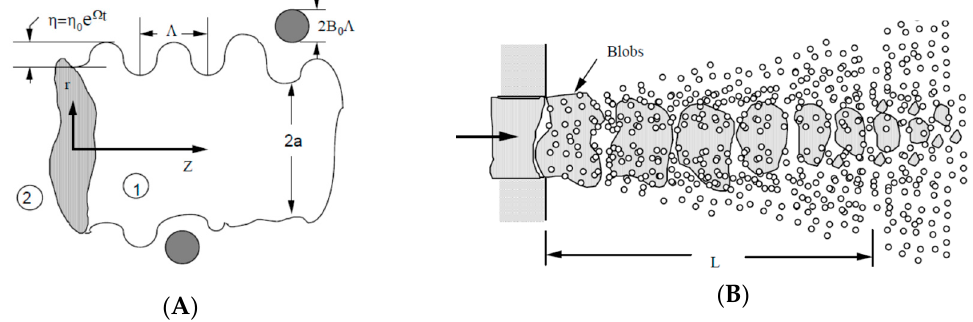
Figure 5. Schematic diagrams of classical models that treat the dense spray region. ( A ) Concept of WAVE model [28]; ( B ) Concept of blob model for numerical implementation [30].